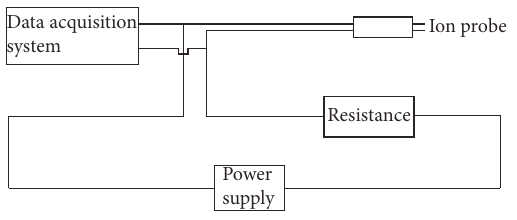
Figure 7: Schematic illustration of the ion probe